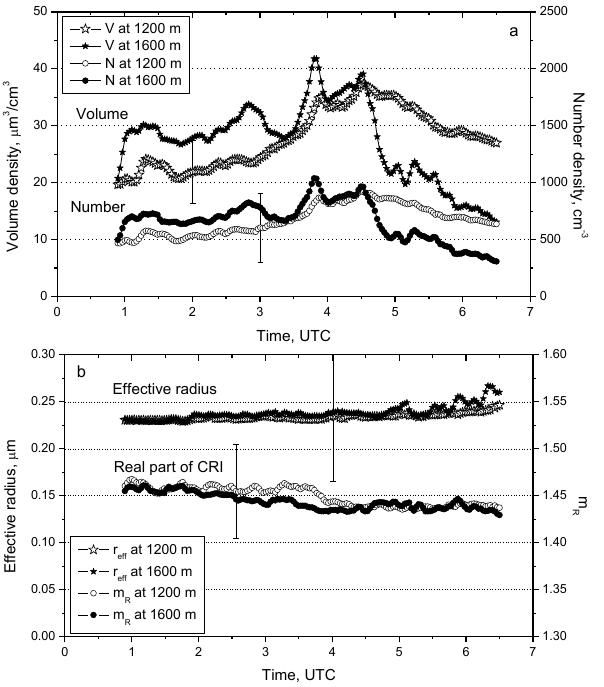
Fig. 9. Time series of (a) particle volume and number density together with (b) effective radius and the real part of the refractive index retrieved from the lidar measurements on 22 July 2011. The lidar derived parameters are averaged in layers of 200 m thickness and centered at 1200 m (open symbols) and 1600 m (solid symbols) height.